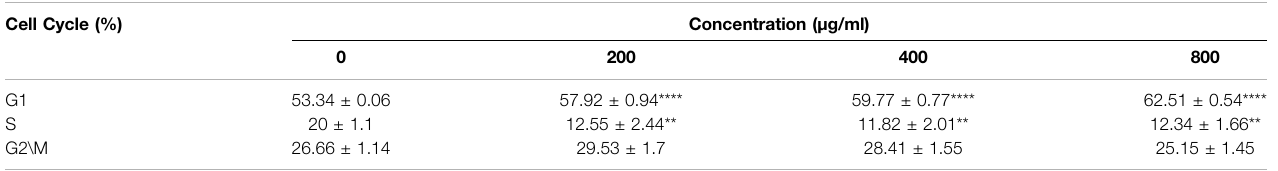
TABLE 4 | Effect of SBP-2A on the cell cycle distribution of HepG2 cells for 48 h ( n = 3). Cell Cycle